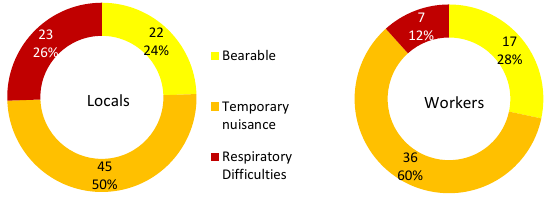
Figure 5: No. of peoples affected by Dust due to project activities w.r.t. locals vs workers.